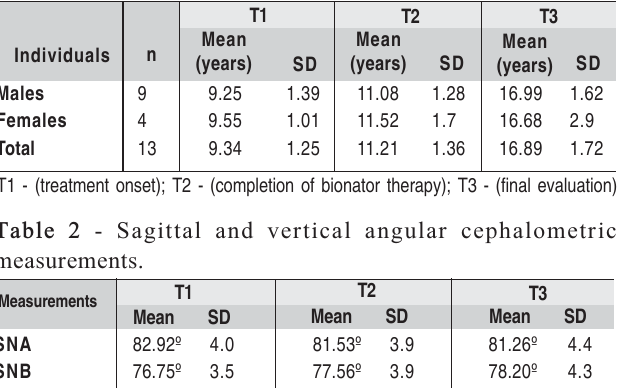
Fig. 2 . Partial superimposition on the mandible, transference of the three fiducial points, and construction of HL(Horizontal Line) and PVL(Posterior Vertical Line). Table 1 - Characteristics of the study sample